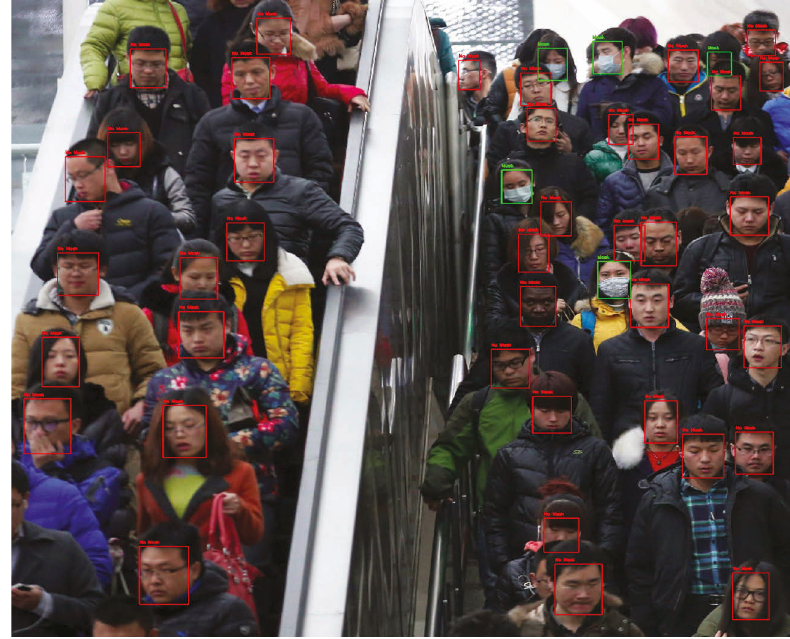
Figure 24: Proposed system has high accuracy with multiple